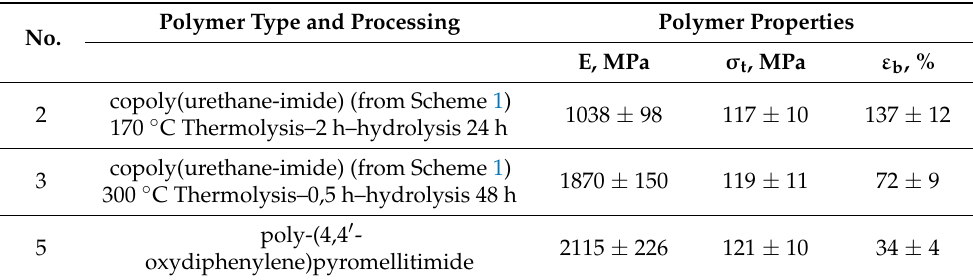
Table 2. Deformation–strength properties of polymer films obtained as a result of selective destruc- tion of urethane blocks in copoly(urethane-imide) in the processes of thermolysis and subsequent hydrolysis of initial